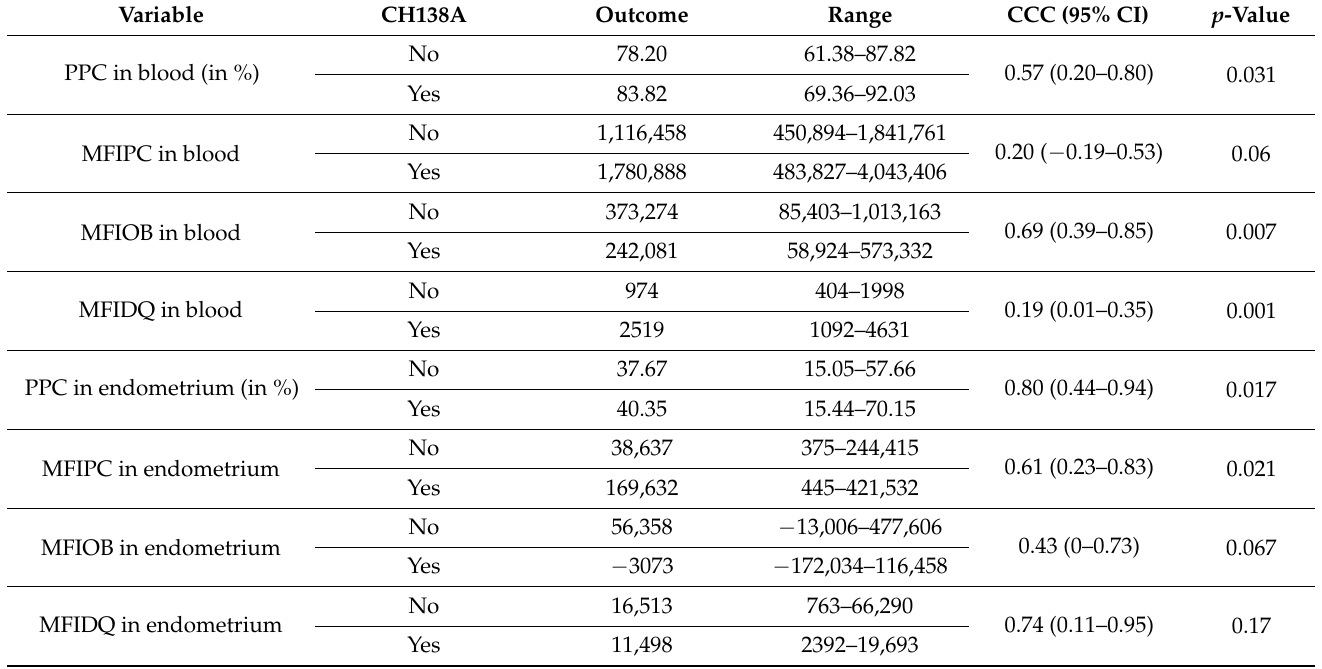
Table 3. Flow cytometric evaluation of polymorphonuclear leukocyte (PMN) functionality via oxidative burst (OB), phagocytosis (PC), and intracellular proteolytic degradation by DQ ovalbumin (DQ-ova) with or without prior CH138A immunolabeling. Blood and endometrial samples ( n = 11) were collected from Holstein-Friesian cows at 9–37 days in milk. Samples were processed in duplicate, with or without prior CH138A immunolabeling. For both cases, the PMN gating strategy was solely based on morphometrical characteristics (high FSC and high SSC) and results were compared inter-assay. The functionality outcomes included: percentage of PMN that performs PC (PPC), median fluorescence intensity (MFI) of PMN that displayed OB (MFIOB), PC (MFIPC), or DQ-ova (MFIDQ) relative to the MFI of the respective autofluorescence control. CH138A = specific bovine granulocyte marker. Lin’s concordance correlation coefficient (CCC) and 95% confidence interval (CI) are reported with the p -value from the corresponding Pearson (parametric) or Spearman (non-parametric) test. Correlations were considered significant at p <